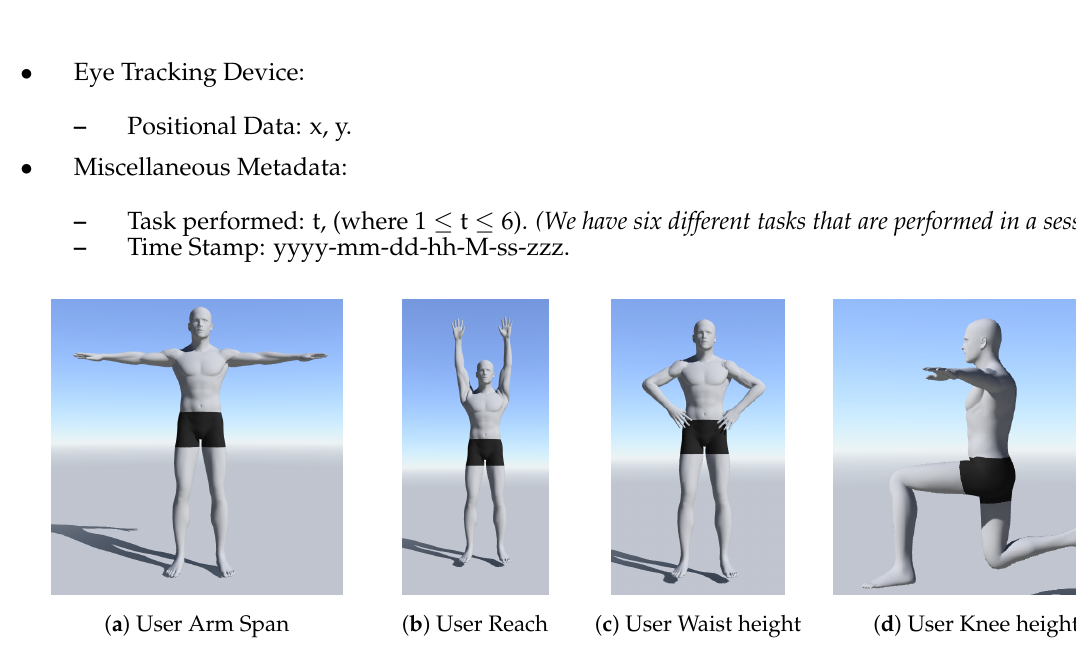
Figure 6. Pre-Experiment measurements: The Participants’ body metrics were taken before the initial experiment session commenced. The data were used to configure the VR environment to ensure that all participants would have similar experiences in the